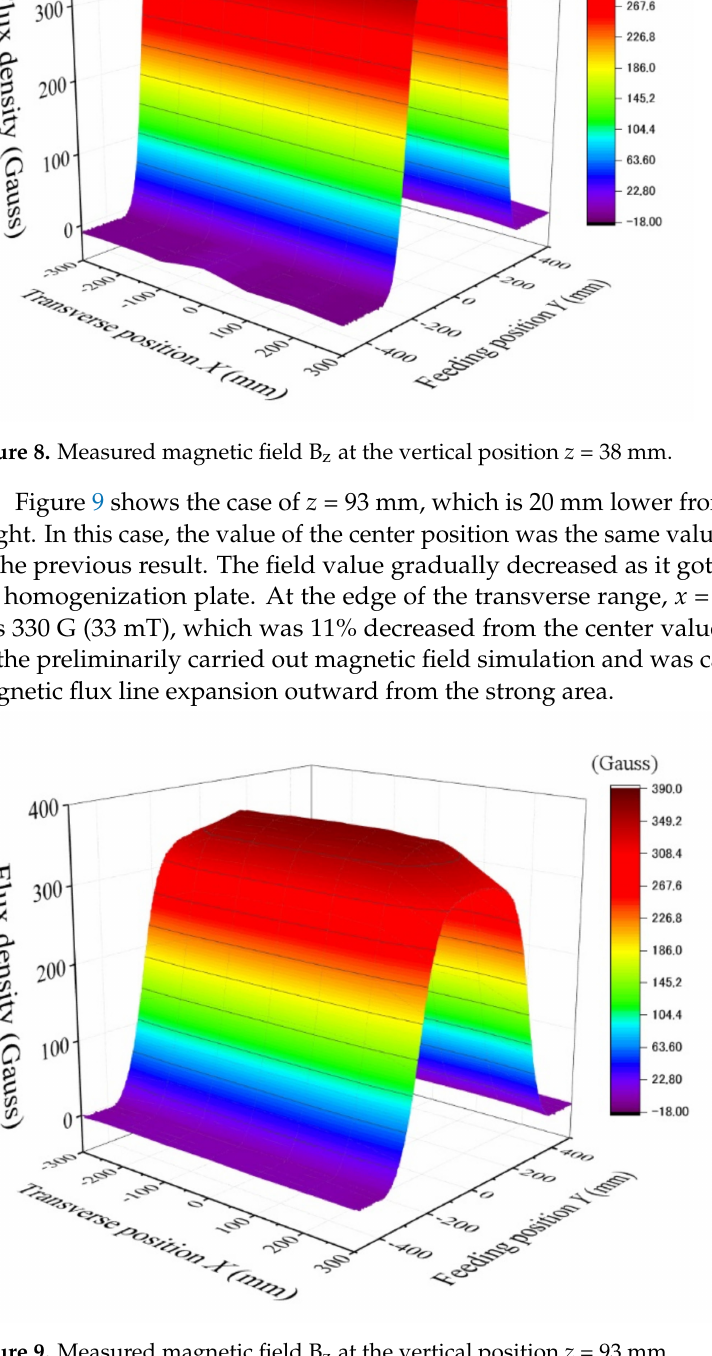
Figure 9. Measured magnetic field B z at the vertical position z = 93 mm. Figure 10 is the overlapping expression of the field variation as a parameter of vertical height z . The horizontal axis represents the feeding position Y, and the vertical axis represents the flux density B z . The transverse position was fixed at x = 0, which was on the center line. The parameter z ranged from z = 38 mm to z = 174 mm, which was within the distance between the homogenization plates, 225 mm. The result show that the vertical flux density was almost the same value independent of the height position. Of special